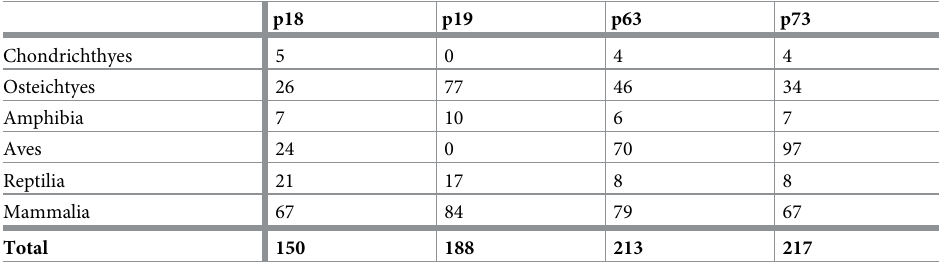
Table 1. Number of sequences used in rBH3 conservation analysis.